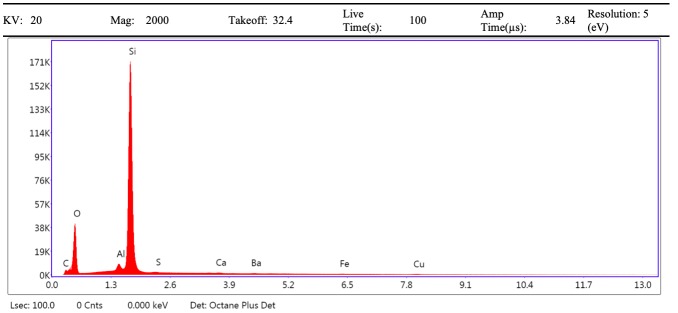
EDS spectrum of vessel exterior (region 1) from demineralised Late Cretaceous Centrosaurus bone area D.